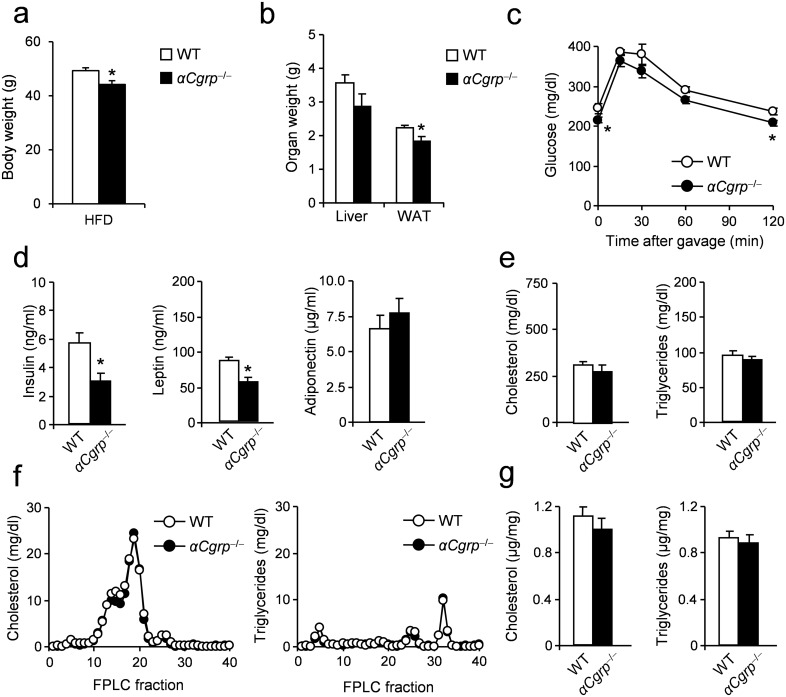
Effects of DIO on metabolic parameters in mice lacking αCGRP.(a) Body weight in αCGRP-deficient mice and controls fed HFD for 16 weeks. (b) Organ weights (epididymal WAT, white adipose tissue) after 16 weeks of feeding. (c) Plasma glucose concentrations during OGTT (1 g/kg) following a 4h fasting period in αCGRP-deficient mice and controls after 16 weeks of feeding. (d) Plasma levels of insulin, leptin and adiponectin in the same mice. (e) Total plasma cholesterol and triglycerides concentrations in the same mice. (f) Cholesterol and triglycerides FPLC profile from pooled plasma (n>8) in αCGRP-deficient mice and controls fed HFD for 16 weeks. (g) Total hepatic cholesterol and triglycerides concentrations in αCGRP-deficient mice and controls fed HFD for 16 weeks. Results are shown as means ± SEM (n = 8–10). *P < 0.05.